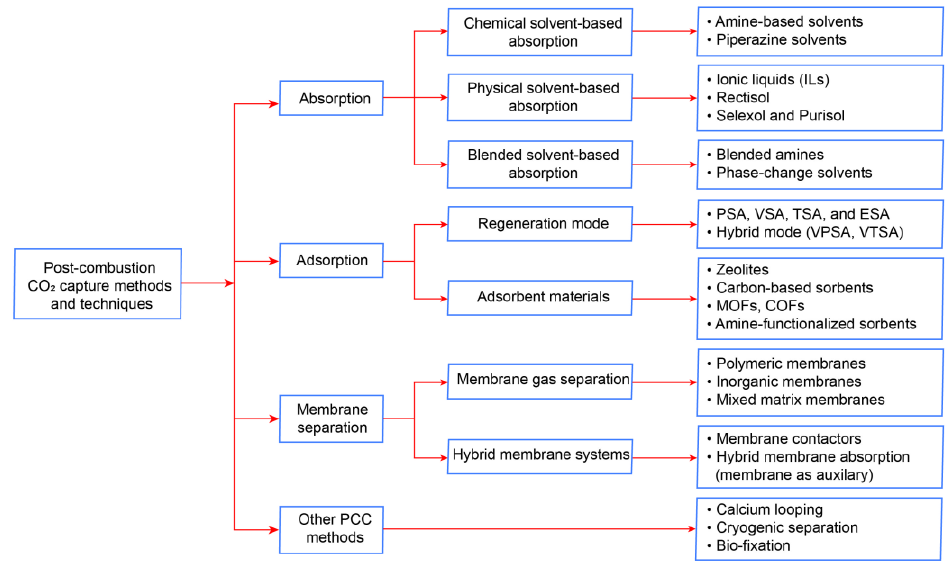
Figure 4. Process technologies for post-combustion capture.